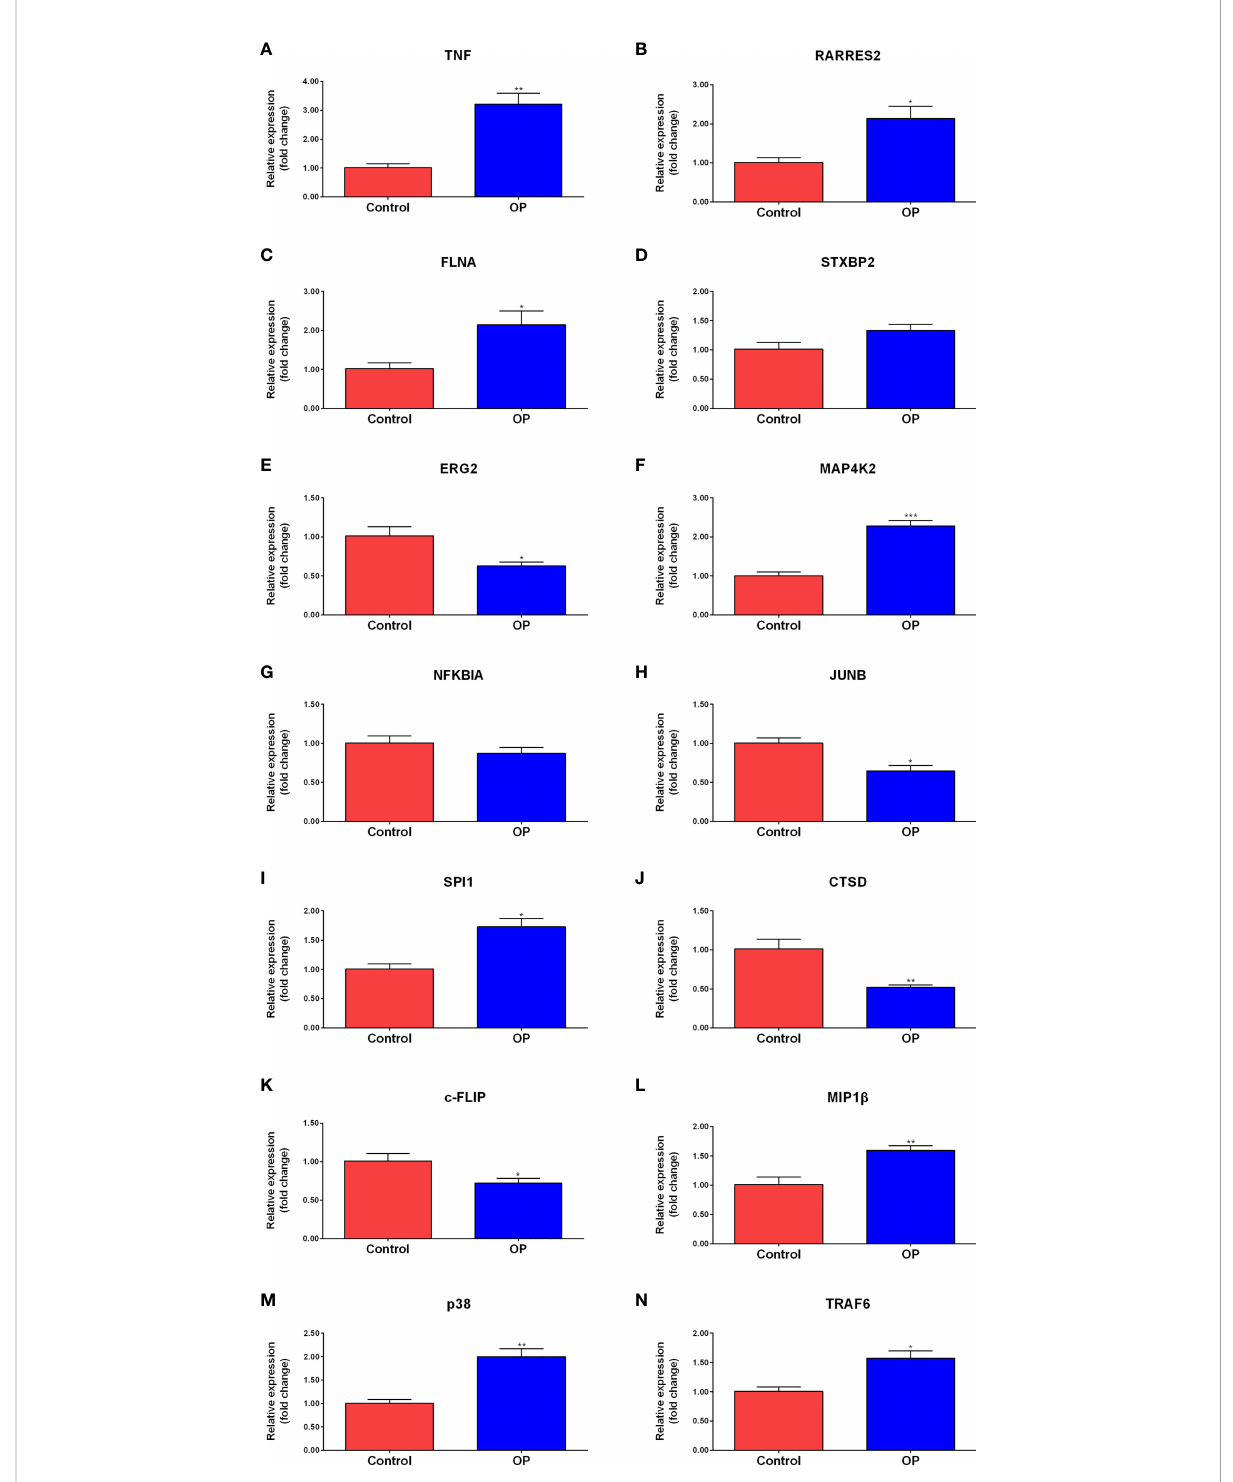
FIGURE 6 RT-qPCR results of the expression level of Hub genes and signaling pathway molecules. Comparison of mRNA expression levels of 10 Hub genes and 4 signaling pathway molecules in plasma of control group (n=3) and OP group (n=4). Among them, the mRNA expression levels of TNF (A) , RARRES2 (B) , FLNA (C) , MAP4K2 (F) , SPI1 (I) ,MIP1b (L) , p38 (M) , and TRAF6 (N) in the plasma of the OP group were signi fi cantly increased. the mRNA expression levels of EGR2 (E) , JUNB (H) , CTSD (J) and c-FLIP (K) were signi fi cantly decreased in the OP group. There was no signi fi cant difference in the mRNA expression levels of STXBP2 (D) and NFKBIA (G) between the two groups. P-values were calculated using a two-sided unpaired Student ’ s t-test. (*P < 0.05, **P < 0.01,***P < 0.001 vs.